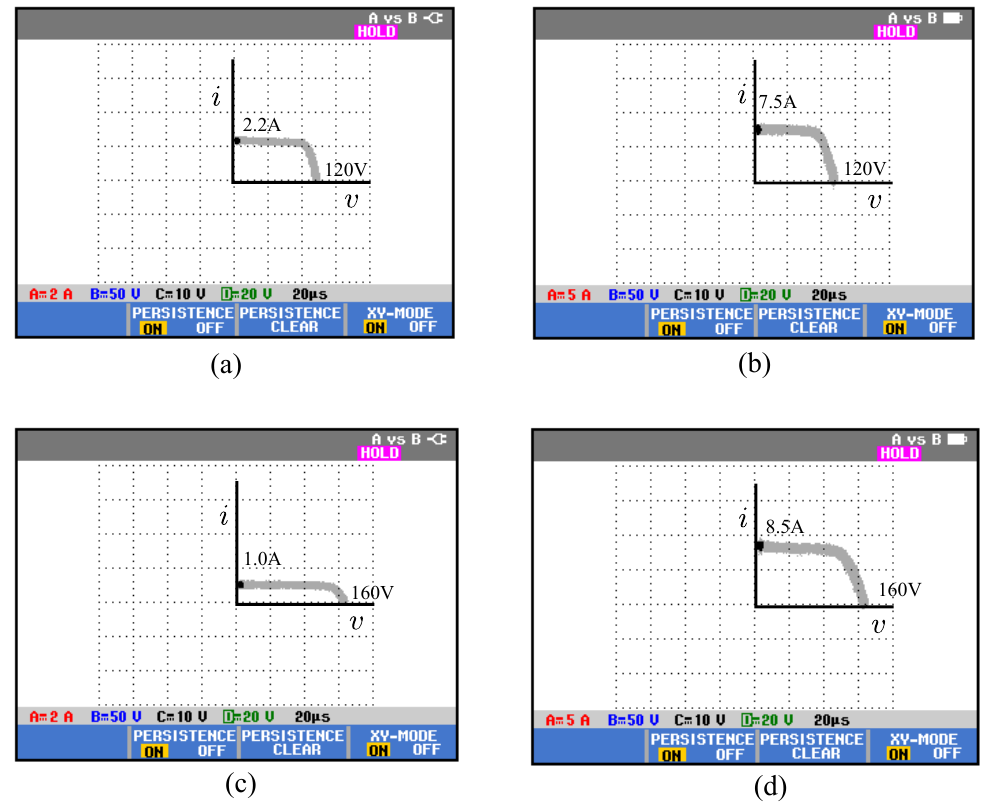
Figure 13. Measured current-voltage characteristics as obtained from the developed characterization system for ( a ) cloudy sky irradiating three PV panels connected in series, ( b ) bright sky irradiating three PV panels in connected in series, ( c ) cloudy sky irradiating four series connected PV panels ( d ) bright sky irradiating four series connected panels. Each polycrystalline PV panel under test is rated at 300 W. Scale: ( a ) current on y -axis is 2 A/div, voltage on x -axis is 50 V/div; ( b ) current on y -axis is 5 A/div, voltage on x -axis is 50 V/div; ( c ) current on y -axis is 2 A/div, voltage on x -axis is 50 V/div; ( d ) current on y -axis is 5 A/div, voltage on x -axis is 50